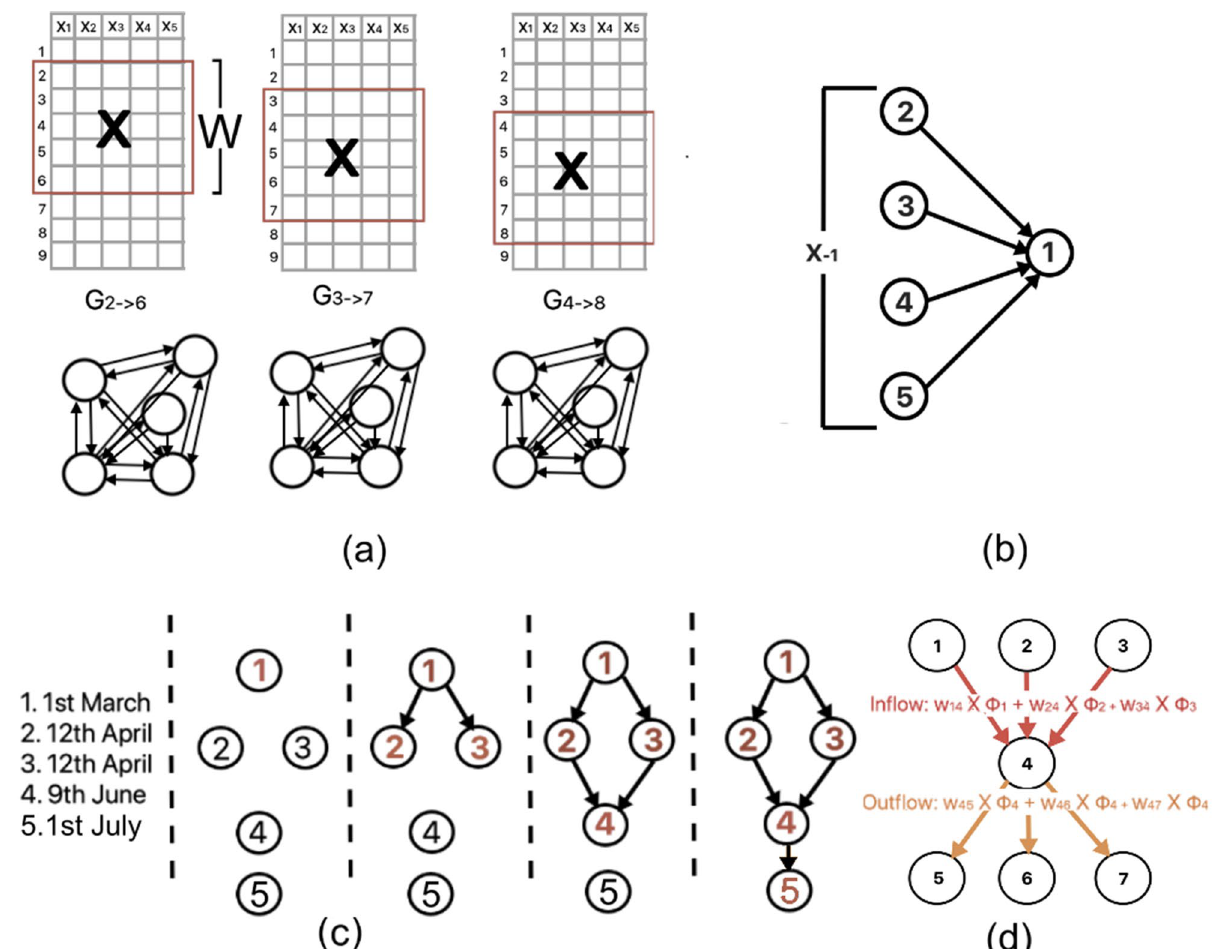
Figure 1. Graph structures. ( a ) Temporal influence networks created from matrix X using sliding time window ( W = 5 ), ( b ) GENIE3 feature ranking technique employed to learn influence of X − 1 on node 1, ( c ) Directed acyclic graph showing relative order of 5 zones based on topological sorting of dates, and ( d ) Inflow and outflow based on weighted degree centrality of node